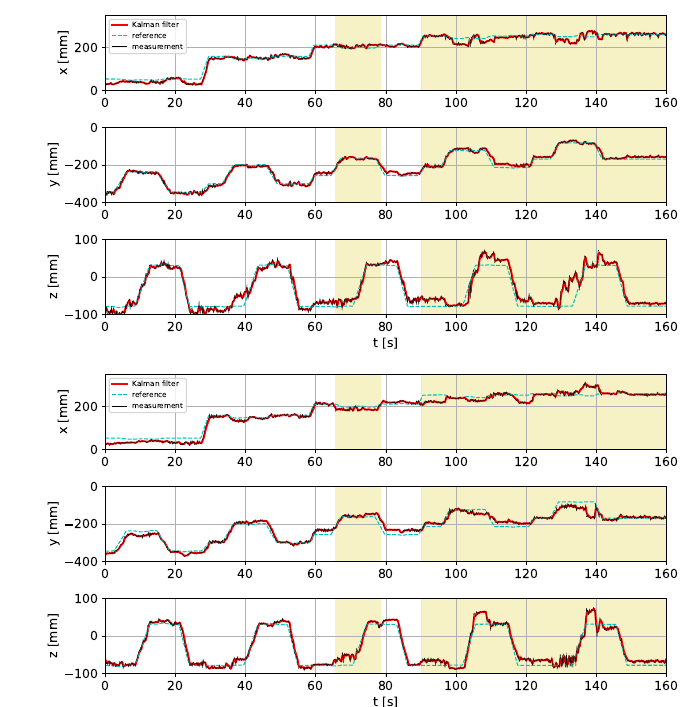
Figure 14. Comparison of the robot position prediction accuracy for graph fitting and sparse CNN on the testing data set, learned on the image from the left camera. The shaded area indicates that the robotic arm is in front of the